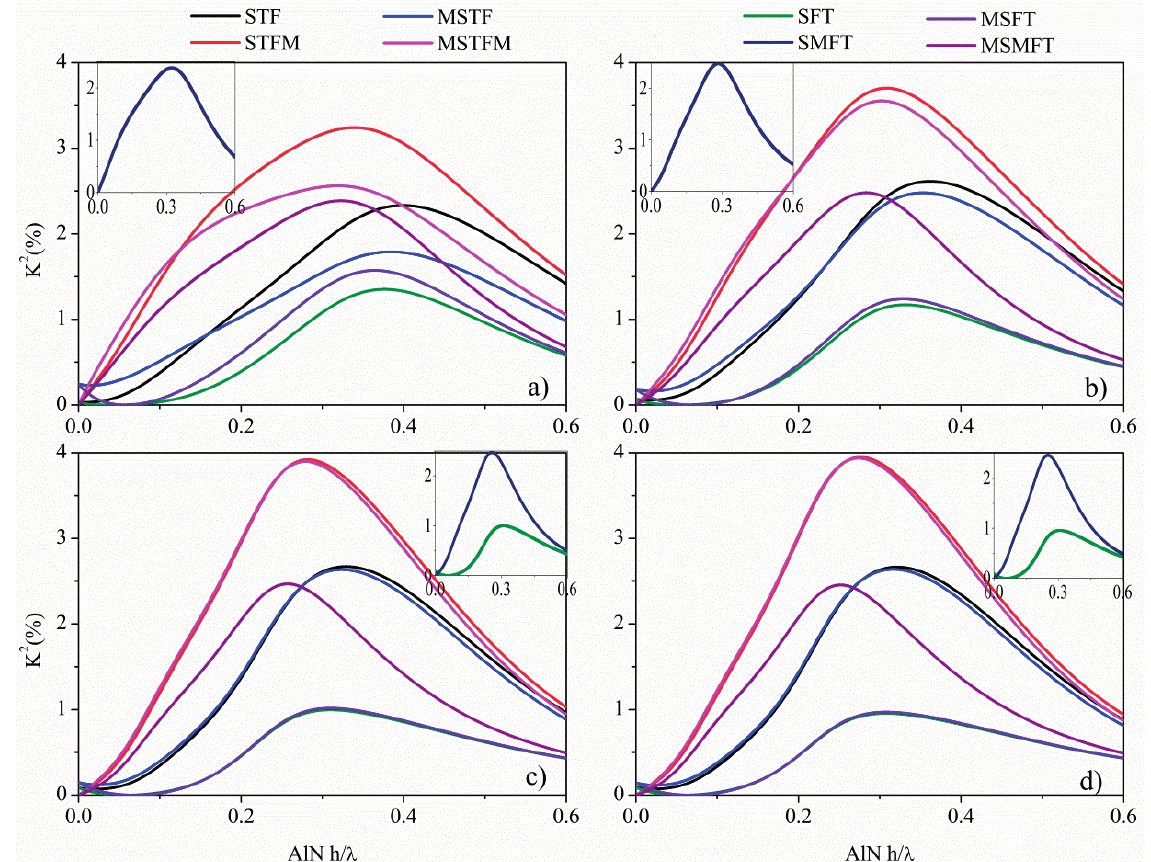
Figure 6. K 2 vs . h AlN / λ dispersion curves of the eight BN/AlN-based coupling structures: ( a ), ( b ), ( c ) and ( d ) refer to h BN / λ = 0.1, 0.2, 0.3 and 0.325,